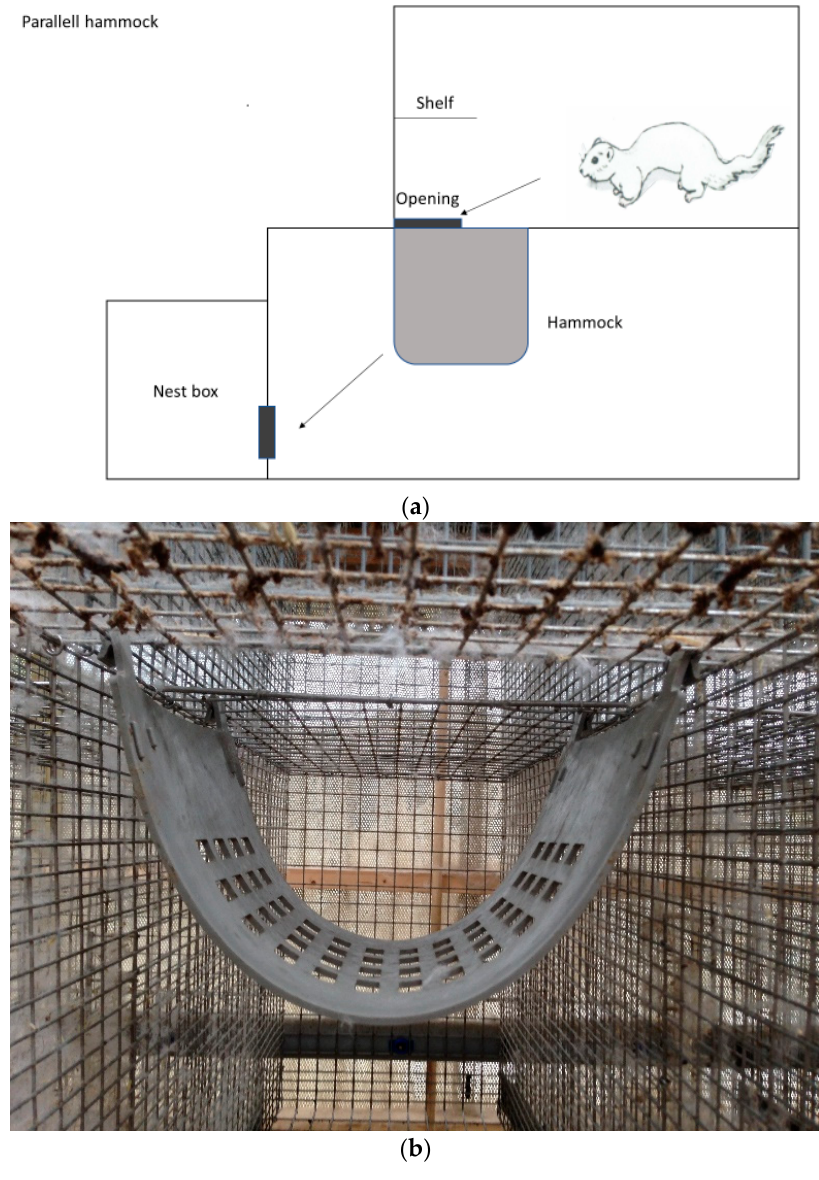
Figure 3. ( a ) Multilevel cage with a hammock installed parallel to the sidewalls, view from the left side. The arrows indicate the chosen route of the mink from the upper floor to the nest box. ( b ) Front view of a hammock placed parallel to the sidewalls.